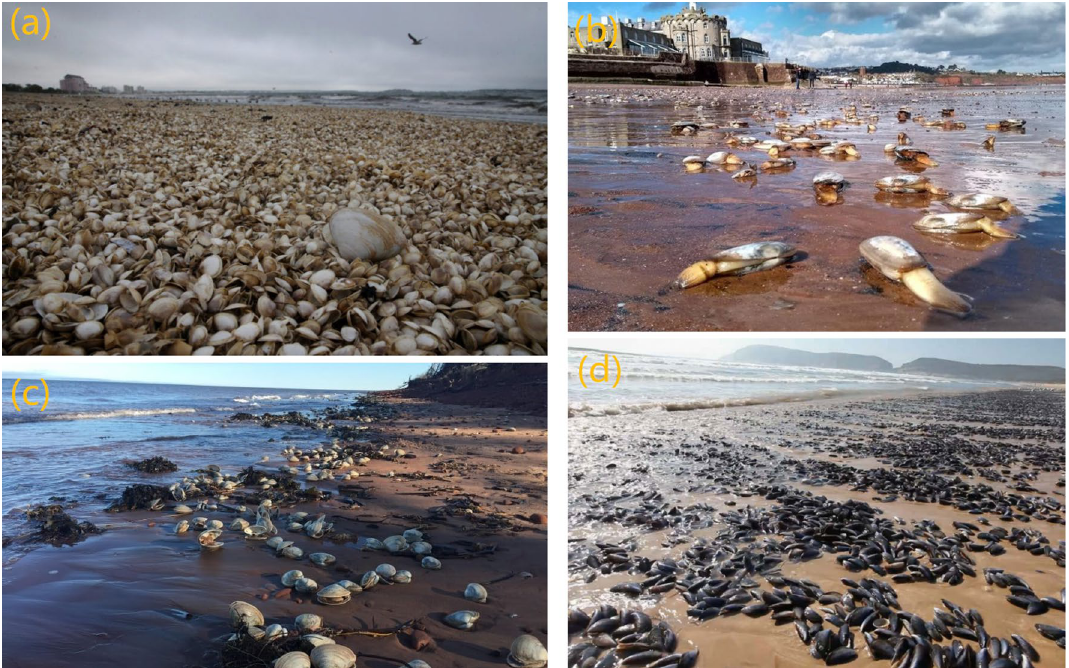
Figure 1. Shellfish washed up on ( a ) Revere Beach, United States in July 2018, © The Boston Globe ; ( b ) Paignton Beach, UK during the storm Emma in March 2018, © DevonLive ; ( c ) the beach at Robinsons Island Canada during the late November storm surge 2018, © CBC News ; ( d ) Rodderg Beach, South Africa in December 2014, © Earth Touch News